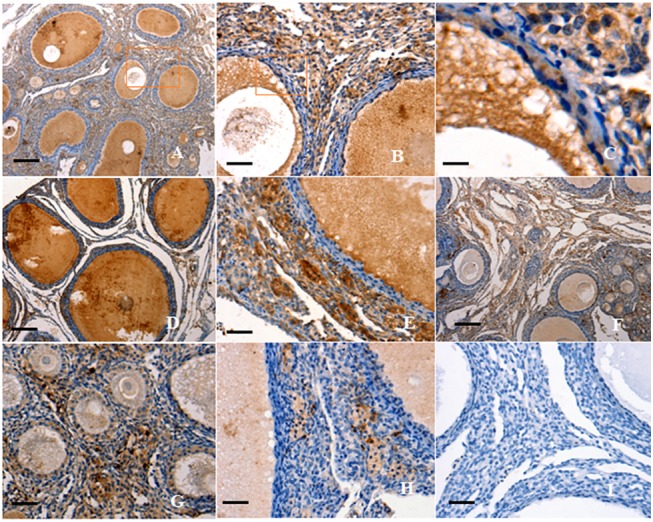
Immunohistochemical analysis of follistatin and activin A protein expression in the ovarian follicle.The sections were immunostained using anti-chicken follistatin (A-E) or anti-chicken activin A (F-H). Panel A shows strong staining of follistatin expression in OC and GCs within the variously sized follicles (×10). Panels B, localization of follistatin protein in the OC and GCs of primary and early prehierarchichal follicles (×40) (< 300 μm in diameter), paralleling the one marked in the box of panel A; Panels C, paralleling the one marked in the box of panel B (×200); Panels D-E, localization of follistatin in large PF (600 μm to 8 mm in diameter; D, ×10; E, ×40); Panel F, staining of activin A expression was observed in OC and GCs within variously sized follicles (×10); Panel G, localization of activin A protein in the OC, GCs, and TCs of primary and early prehierarchichal follicles (< 300 μm in diameter; ×40); Panel H, localization of activin A in large PF (1 to 8 mm in diameter; ×40); Panel I, negative control for activin A, with no significant expression detected (similar negative control for follistatin is not given here). Scale bar = 100 μm.